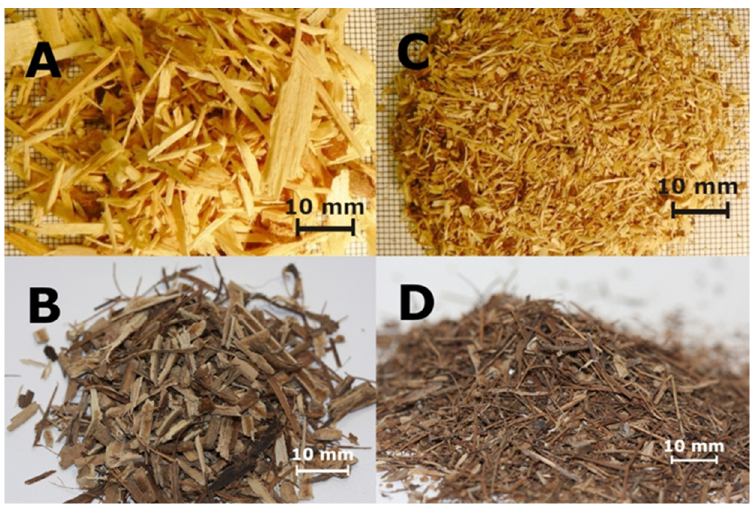
Figure 1. The particles of vine pruning waste: particles for the core layer are ( A ) pinewood and ( B ) vine pruning; particles for the face layers are ( C ) pinewood and ( D ) vine pruning.